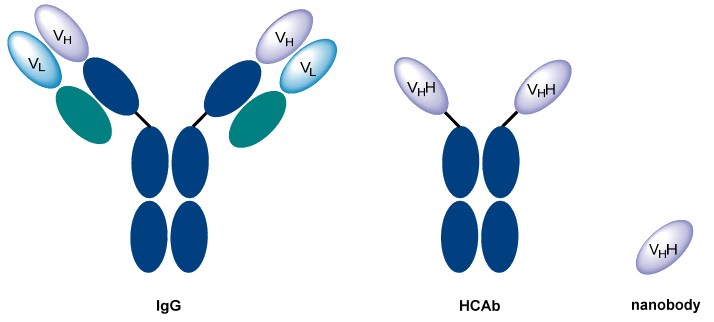
Figure 1. Schematic representation of conventional immunoglobulin G’s (IgGs), heavy chain-only antibodies (HCAbs) and nanobodies. V H , variable heavy; V L , variable light; V H H, V H of HCAbs.